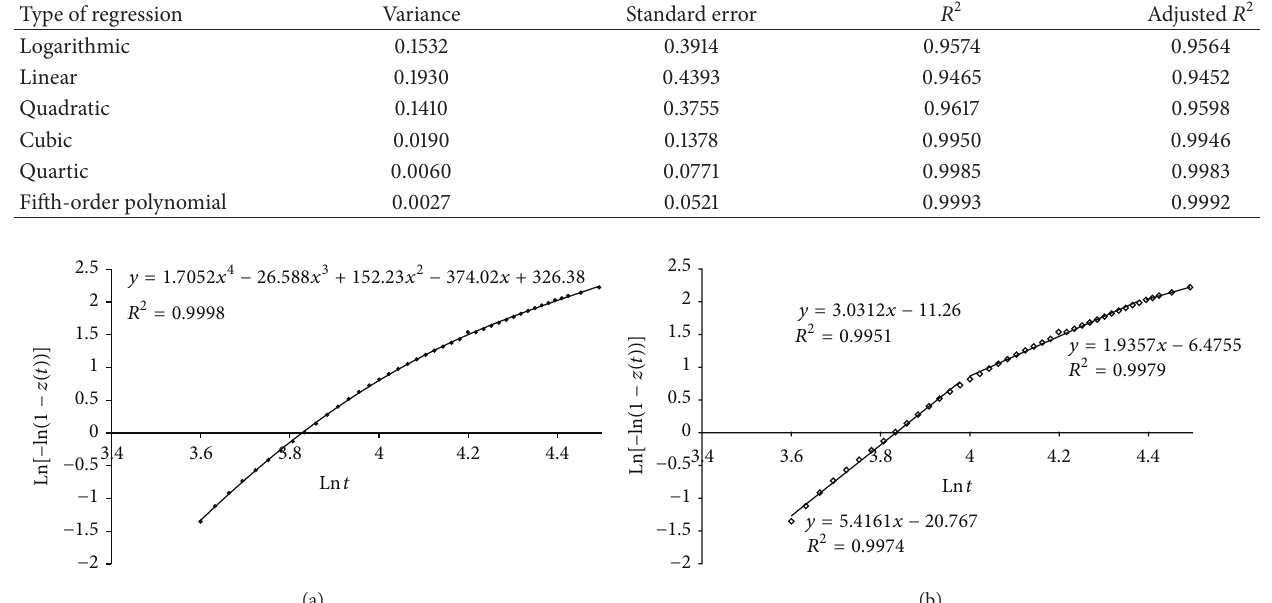
Table 1: Statistical analysis of crystallization data for In at 156 ∘ C in the presence of PTFE 0.5 mm.